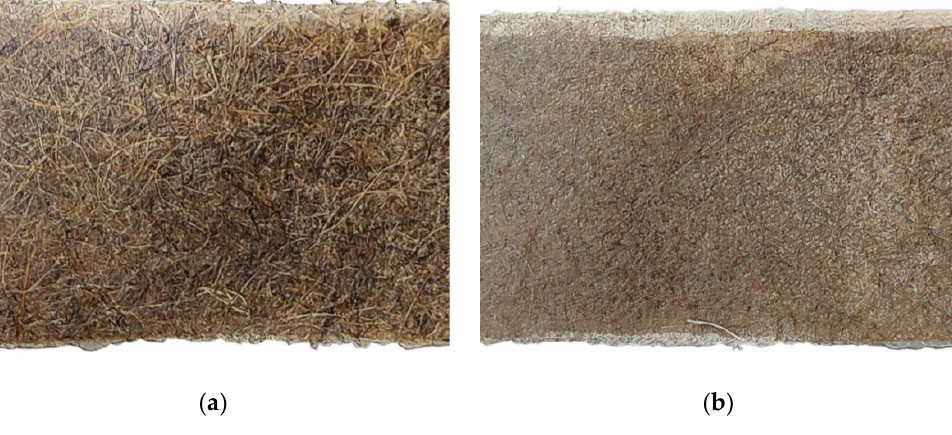
Figure 3. Composite samples: ( a ) hemp/PLA; ( b ) flax/PLA.